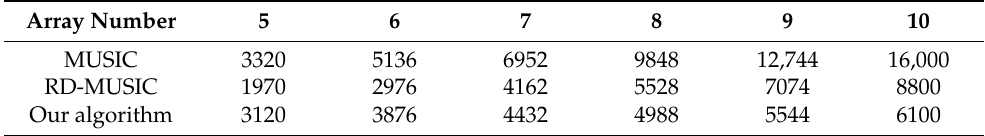
Table 1. Computation of the two